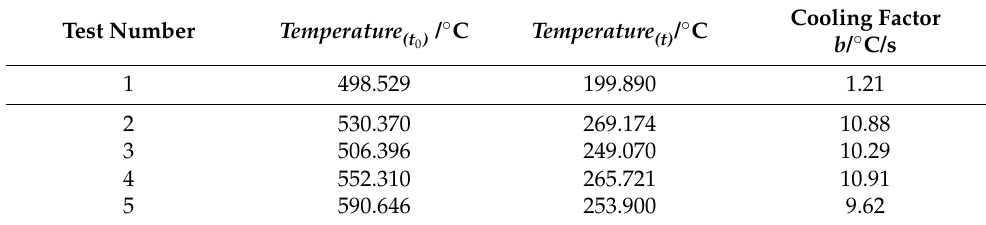
Table 4. Cooling efficiency under different test